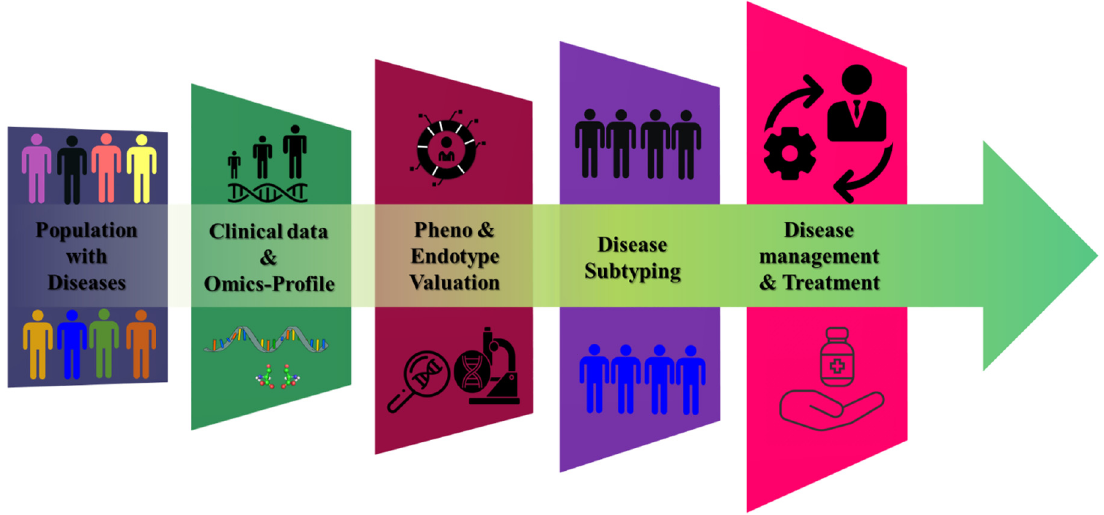
Figure 2: Framework for integration of clinical and multi-omics data for improved disease subtyping within the disease